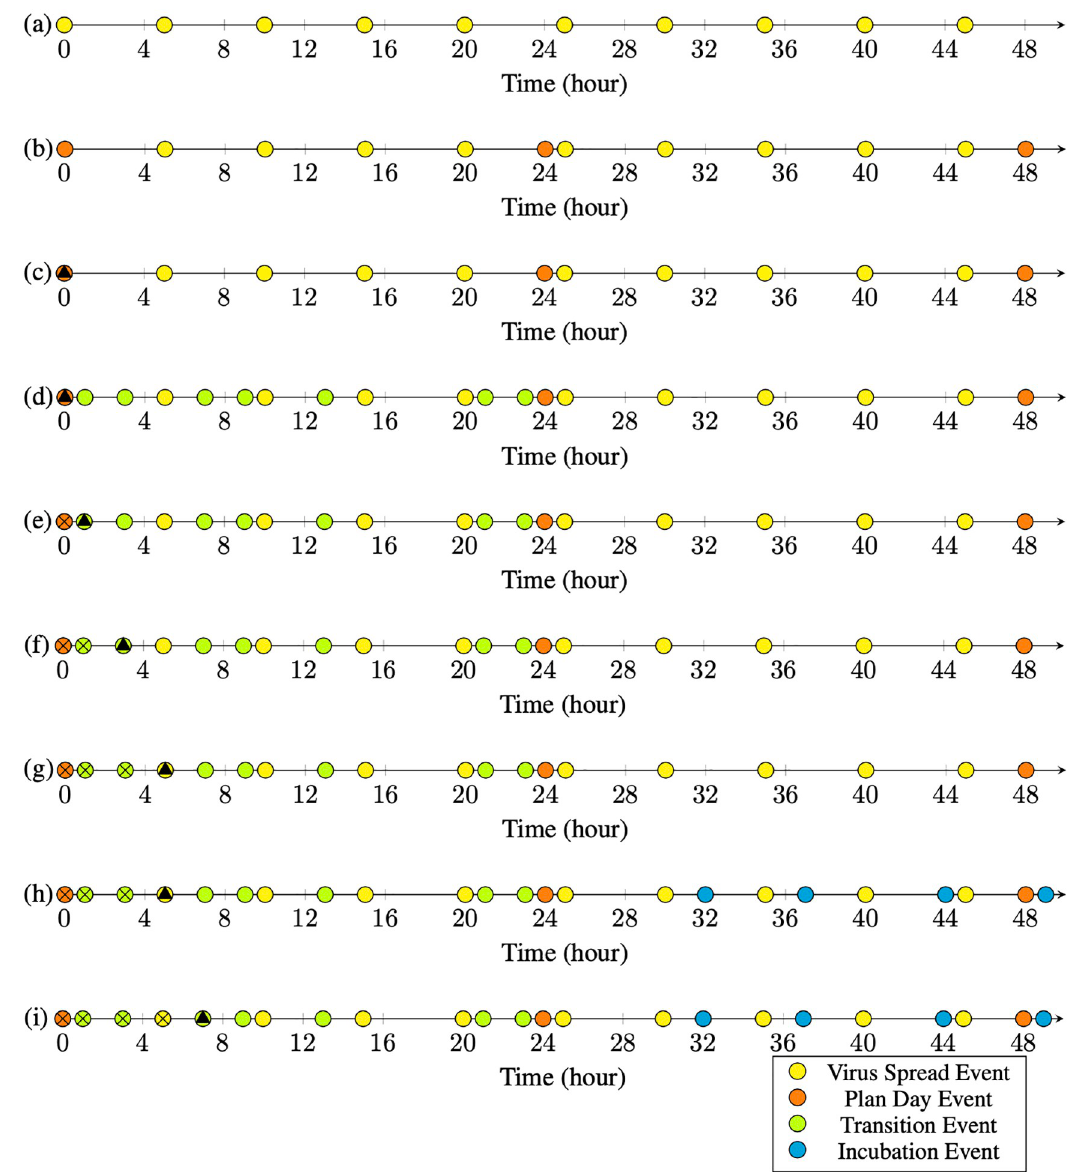
Fig 6. In this figure, a toy example of the execution process for two days is depicted. Events are indicated by yellow circles on the horizontal axis that represents the timeline. The current time of the simulation is shown by the filled triangle. The crossed circles represent those events that are already executed. After the execution of each event, the simulator time jumps forward to the nearest event in the queue. Each row of this figure shows one step of the simulation time. a) The simulator is initialized. The clock period is set to 5 hours based on which the virus spread events are placed. For better illustration, in this plot the virus spread events are placed exactly at the ends of the intervals; but in simulations, they are uniformly distributed within each interval. b) The planned day events are placed at the beginning of each day. These events are supposed to schedule the individuals’ daily lives based on their roles in society. c) The timer is set at the start of the simulation time. d) During the execution of the planned day events, transition events are added to the event queue. These events will change the location of the individuals. e) The timer takes a step forward. f, g) The transition events are executed that change the locations of the individuals. h) The infection is being spread by interactions among individuals. New infections create new incubation events, which are added to the queue. i) The simulation moves on with the same rules.